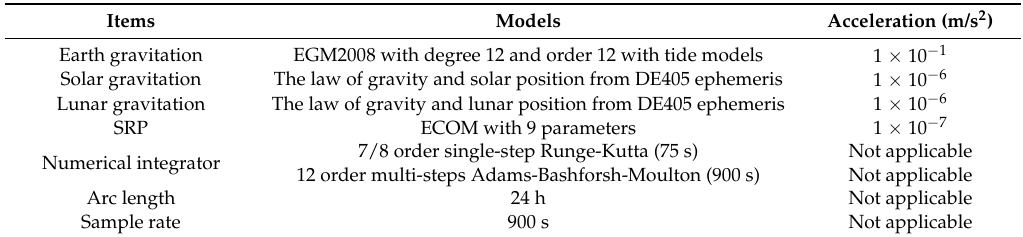
Table 2. Effects of perturbing forces on global positioning system (GPS) satellites and the models applied